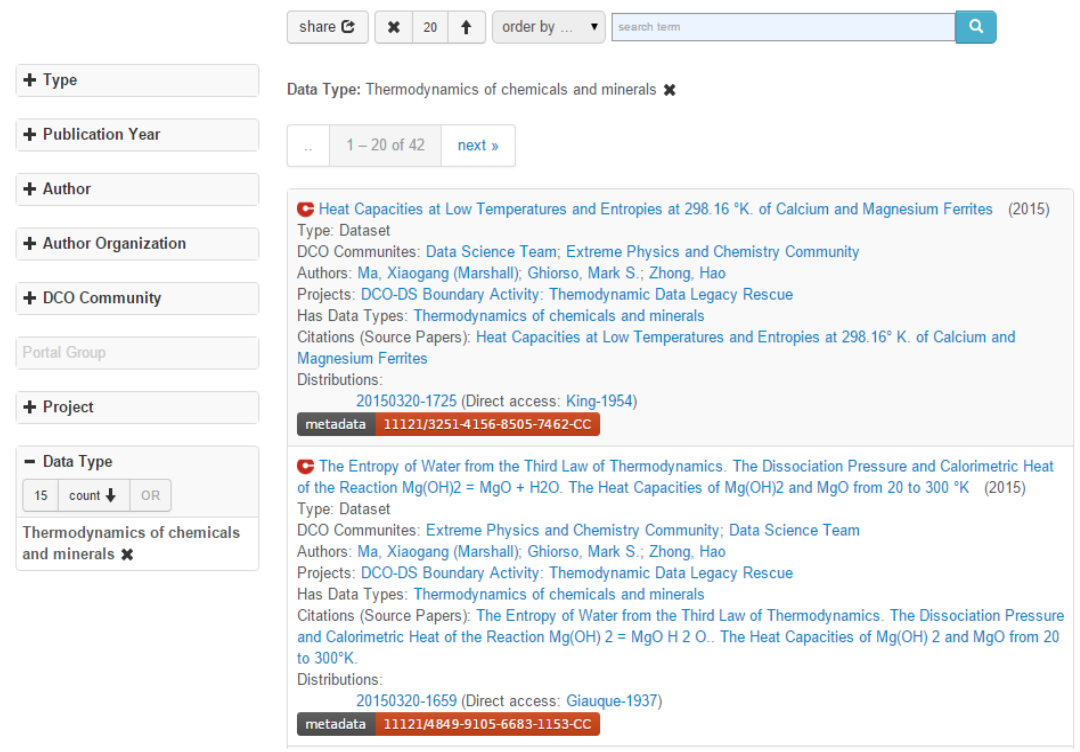
Figure 4. A faceted dataset browser with “Data Type” as a facet.